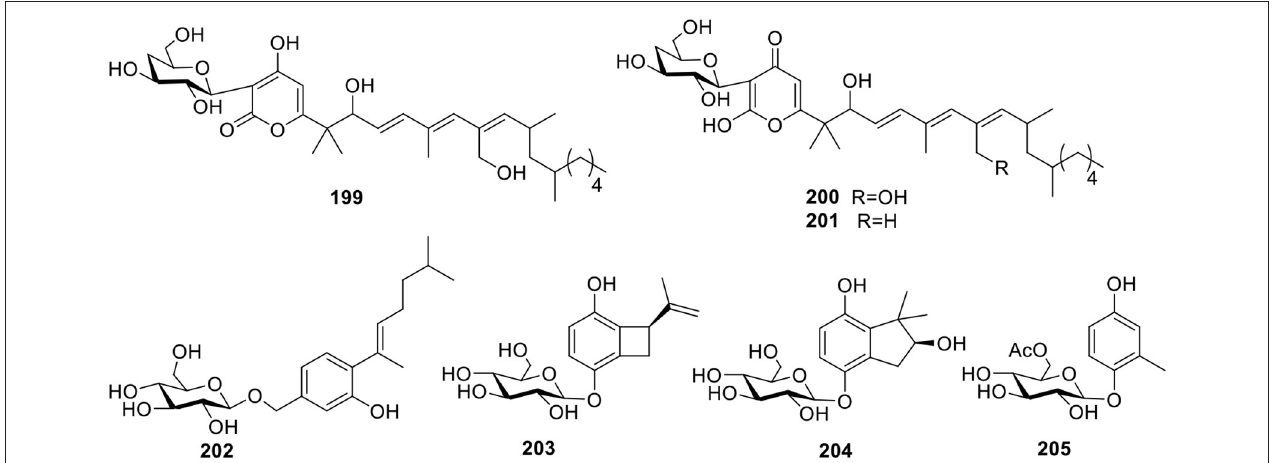
FIGURE 14 | Chemical structures of compounds 199–205 derived from marine-sourced fungi.